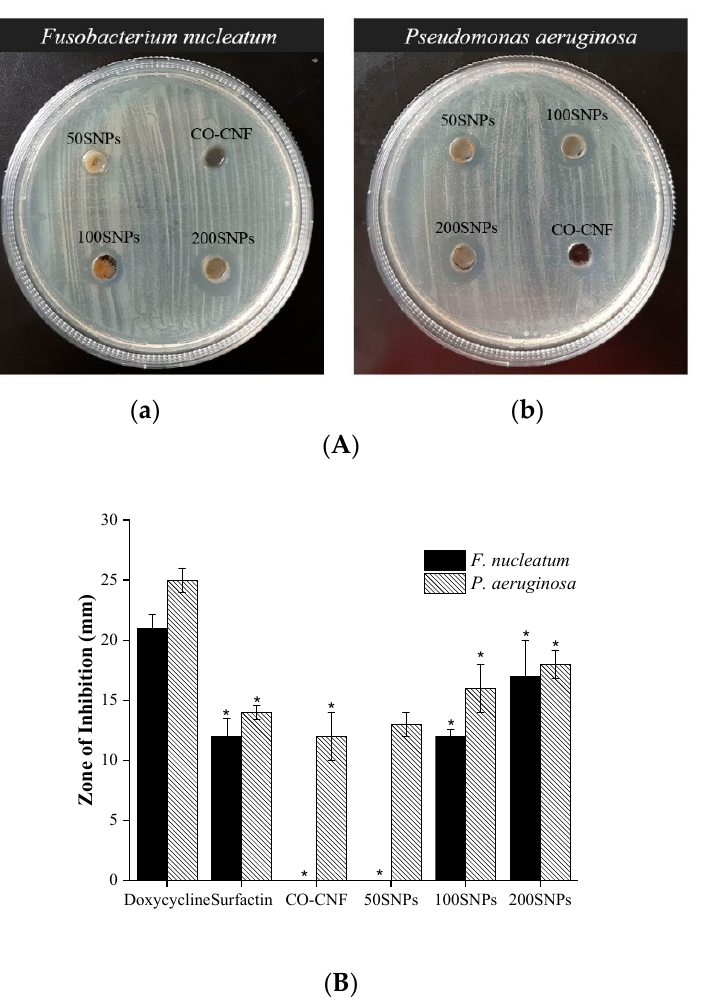
Figure 2. ( A ) Determination of antimicrobial properties of nanoparticles against ( a ) Fusobacterium nucleatum and ( b ) Pseudomonas aeruginosa . ( B ) Zone of inhibition of nanoparticles. Data are expressed as mean ± SD ( n = 3). The asterisk (*) represents a significant difference ( p < 0.05) from the positive control (doxycycline) analyzed by Tukey’s test. CO-CNF: κ -carrageenan oligosaccharides linked cellulose nanofibers; 50SNPs: 50 mg surfactin-loaded CO-CNF nanoparticles; 100SNPs: 100 mg surfactin-loaded CO-CNF nanoparticles; 200S NPs: 200 mg surfactin-loaded CO-CNF nanopar-